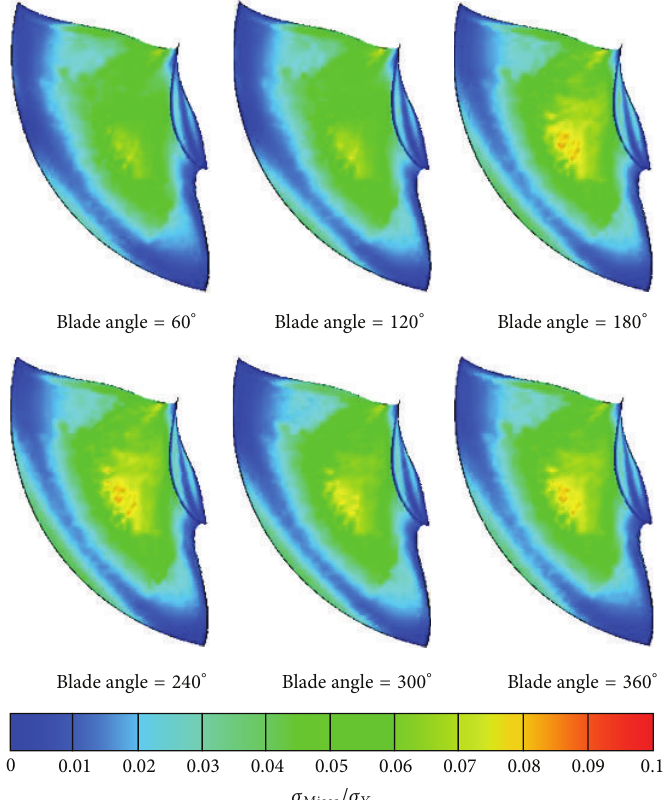
Figure 22: Normalized von Mises stress contours on the pressure side of the rotor blade at various blade angles along one revolution ( 𝜎 𝑌 = 450